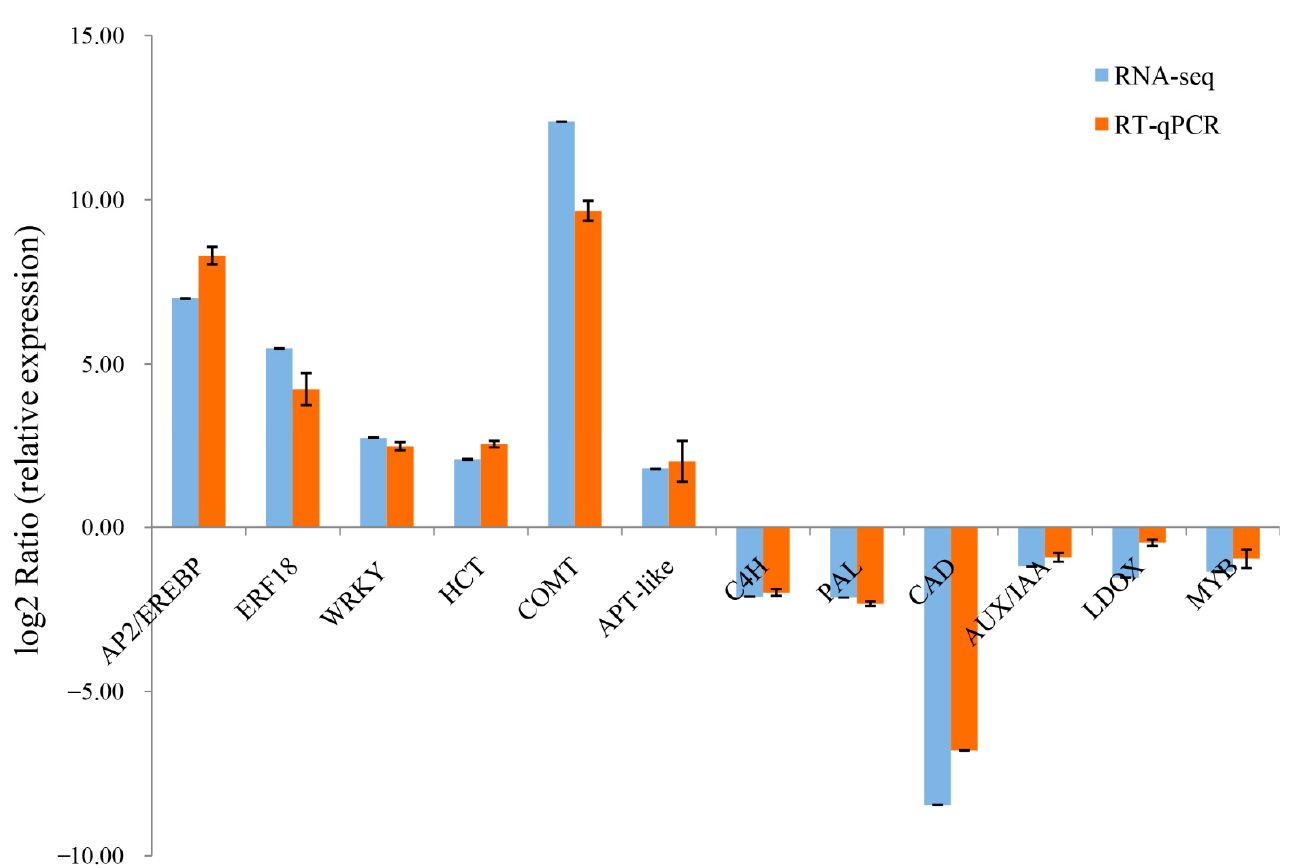
Figure 6. RT-qPCR validation of selected unigenes involved in xylem development. The blue and orange bars represent the normalized relative expression determined by RNA-seq and RT-qPCR, respectively. Error bars ± SE.